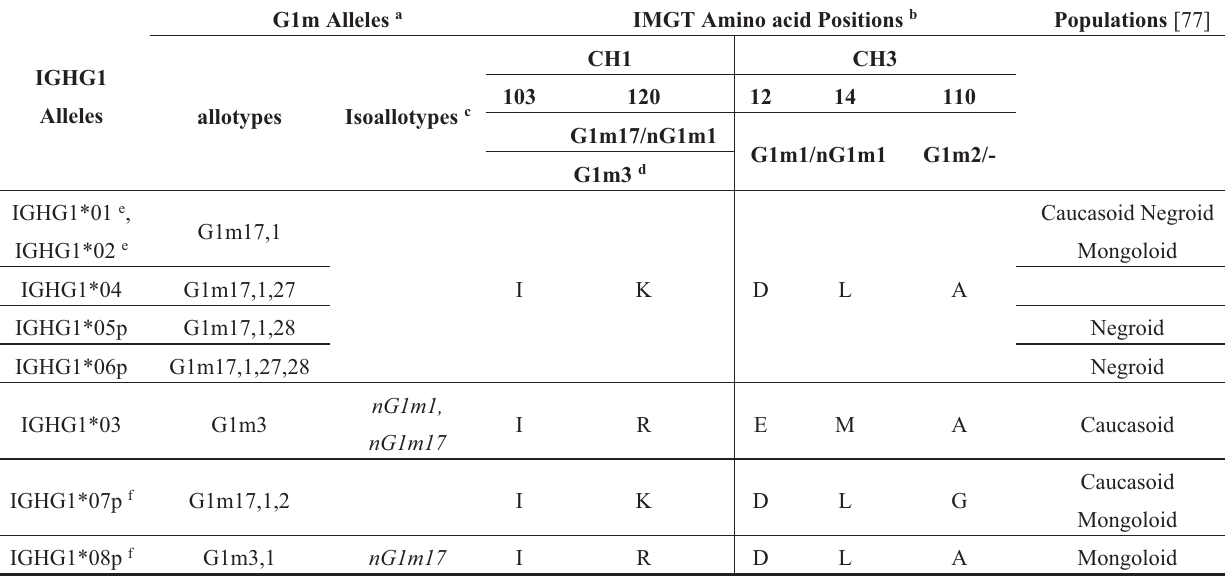
Table 6. Correspondence between the IGHG1 alleles and G1m